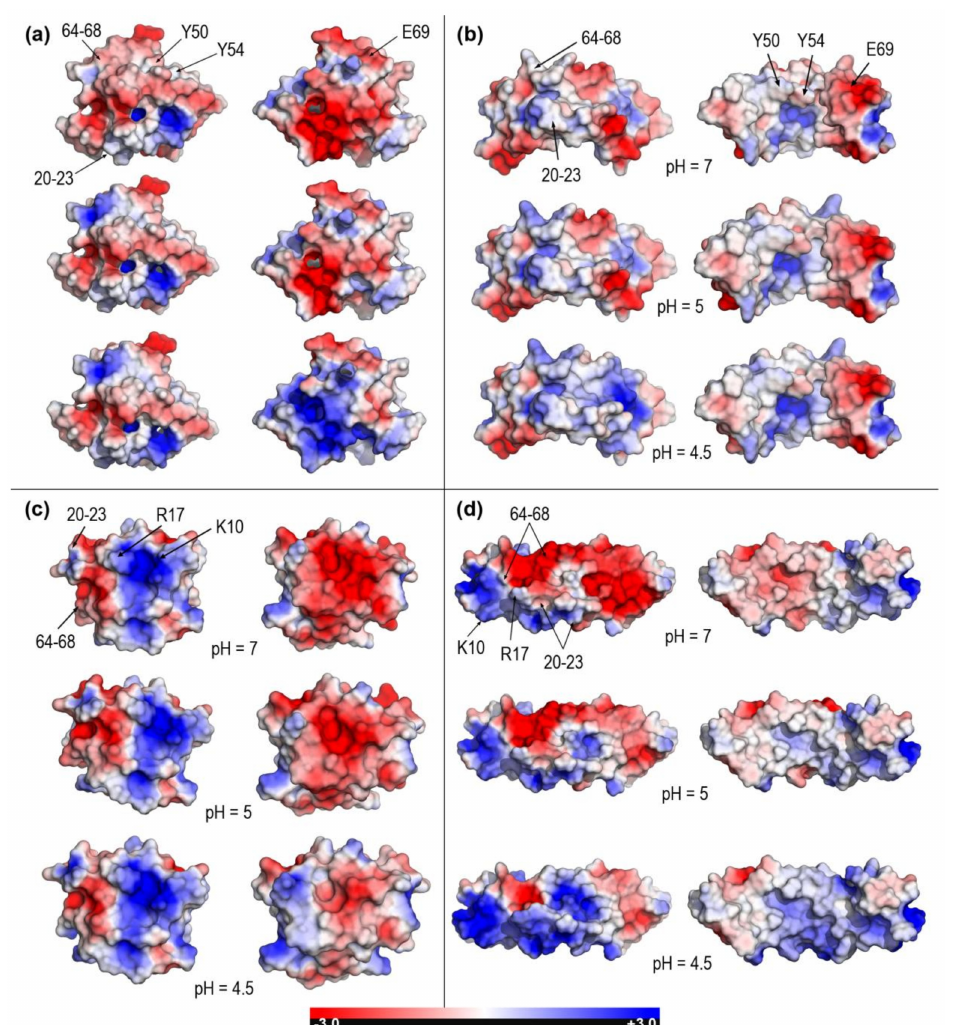
Figure 5. Poisson-Boltzmann electrostatic potential mapped onto molecular surfaces of saposins B and D at pH 7, 5, and 4.5. ( a ) Modeled closed form of saposin B. ( b ) Open form of saposin B (chain A in X-ray structure 1N69). Surfaces of Y50, Y54, and E69 residues involved in drug- and lipid-binding are indicated only in the first row. ( c ) Closed form of saposin D (chain A in X-ray structure 2RB3). ( d ) Modeled form of saposin D. Surfaces of K10 and R17 residues involved in association with anionic headgroups of lipids in membranes are indicated only in the first row. Right views in each panel are obtained from left views upon 180 ◦ rotation around a vertical axis. Segments involved in the closed → open transformation (Figure 2) are labeled only in left images of first